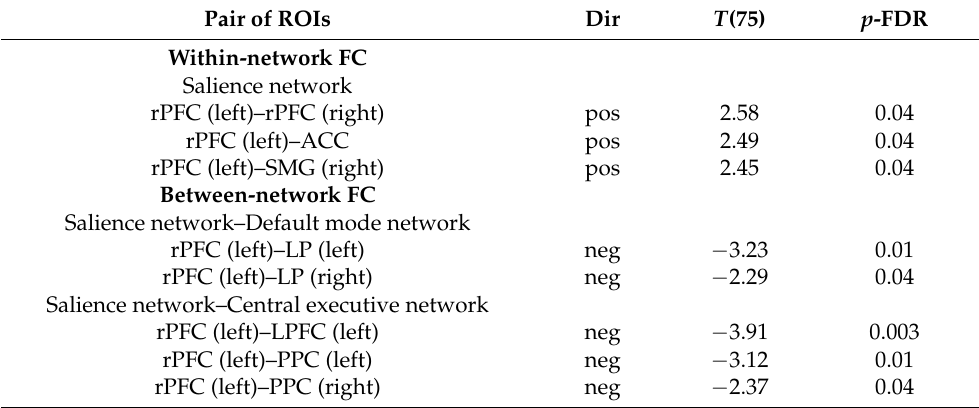
Table 2. Significant associations between BDI-II and ROI-to-ROI FC, sorted by within- and between- network